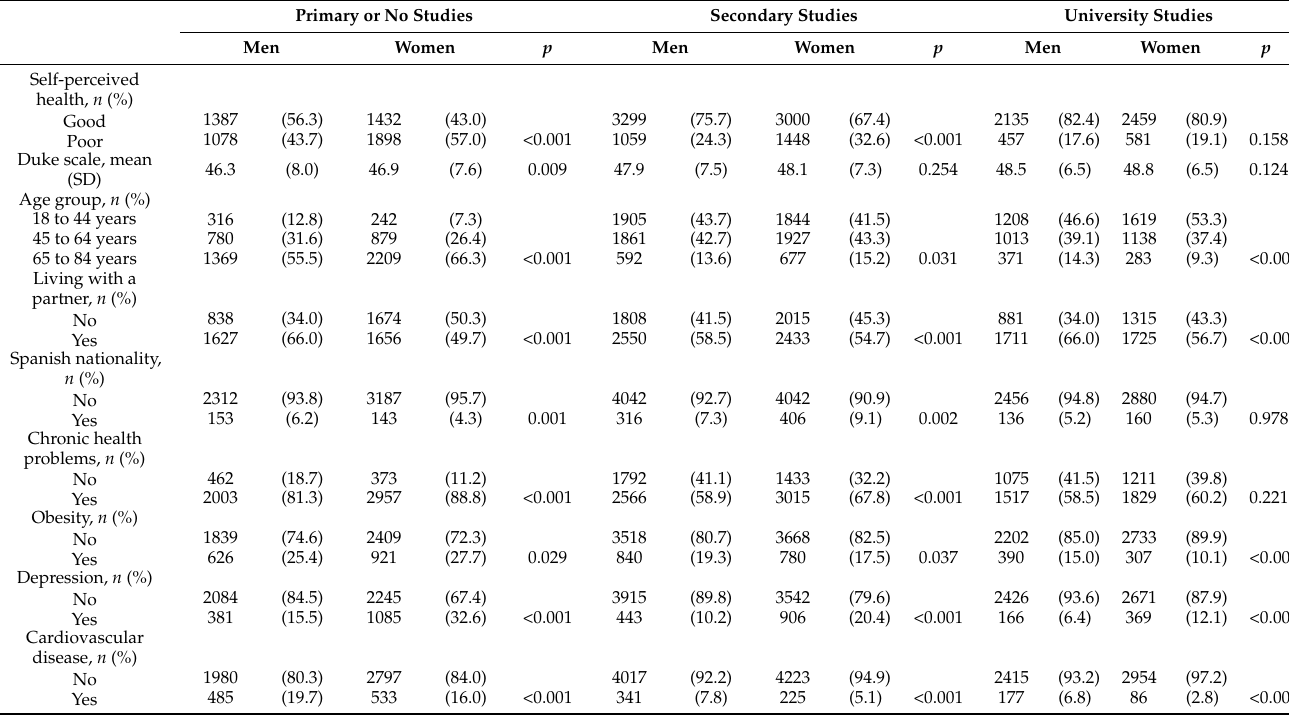
Table 2. Description of the study variables depending on level of education and sex. Adult men and women. 2017 Spanish National Health